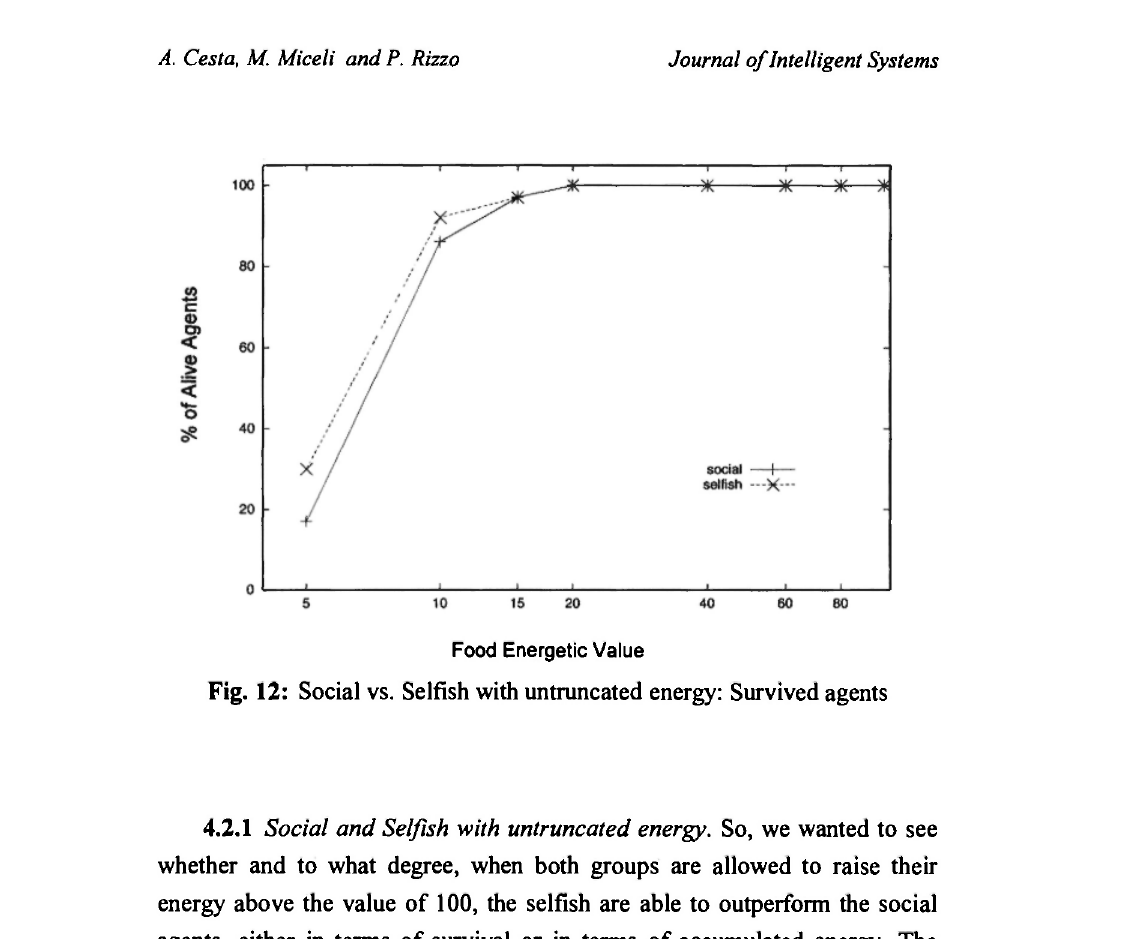
4.2.1 Social and Selfish with untruncated energy. So, we wanted to